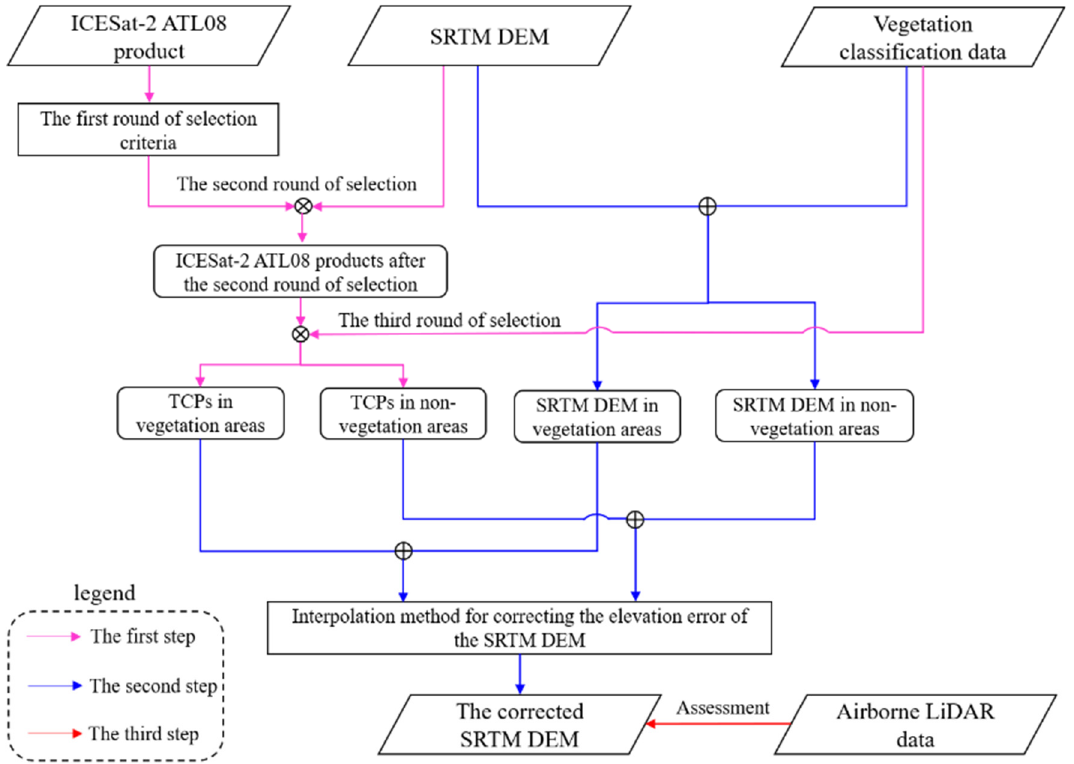
Figure 2. Flow chart of the proposed method.